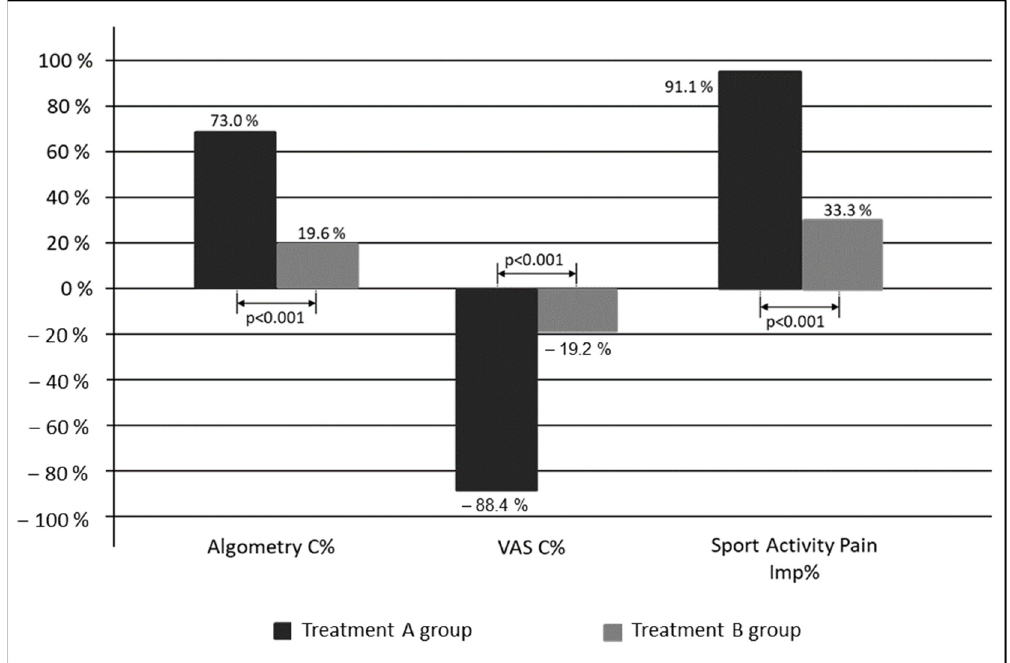
Figure 4. Change and improvement comparison between treatment A and B groups. C% = change %; Imp% = improvement